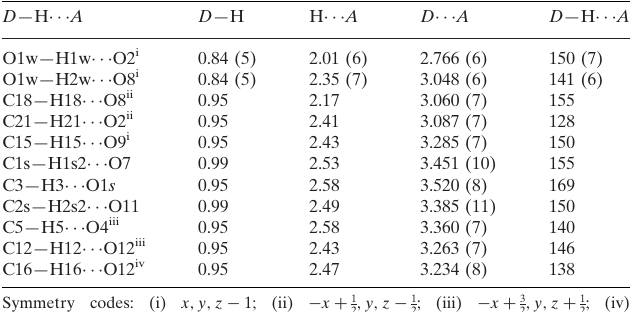
Hydrogen-bond geometry (A˚ , (cid:3)